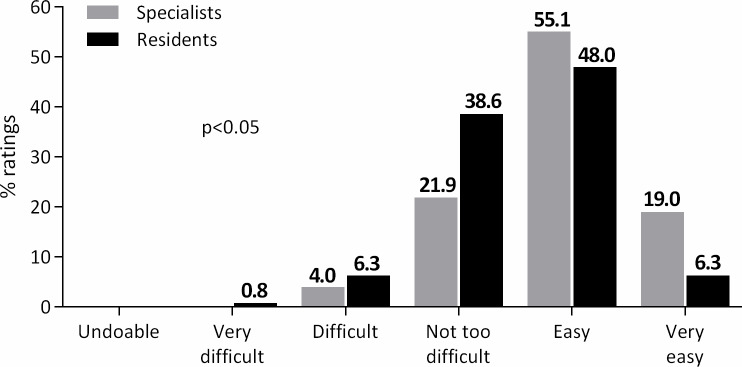
Ratings of the difficulty of the LISA procedure according to the qualification of the proceduralist (specialists vs residents).